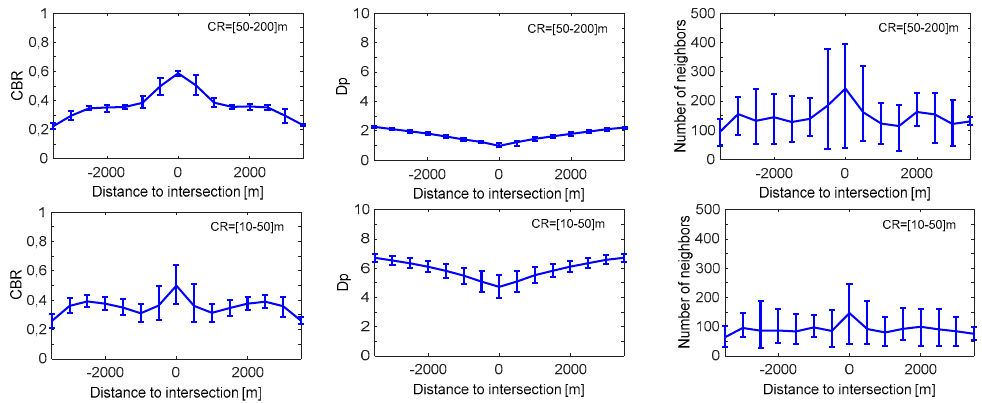
Figure 9. Average of the CBR , D p metric and number of neighbor vehicles when applying COMPASS to coordinate the operation of A-DCC, MINT and TOWER. The results are shown for a traffic density of 75 veh/km/lane and two possible ranges of the communication range ( CR ) requirements: between 50–200 m and between 10–50 m.